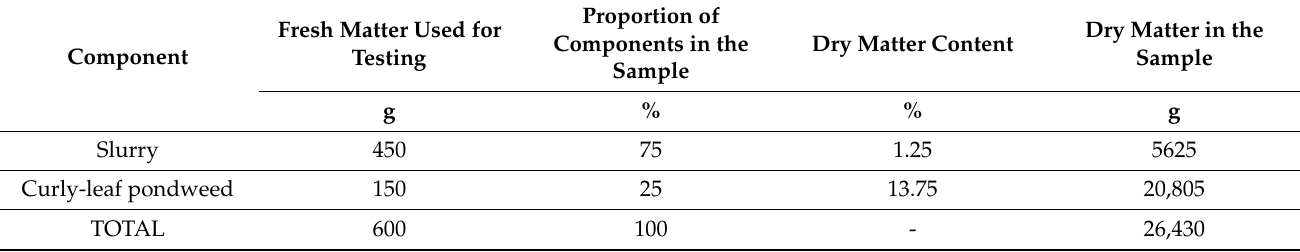
Table 1. Parameters of the slurry and pondweed mixture from Lake Rusalka.